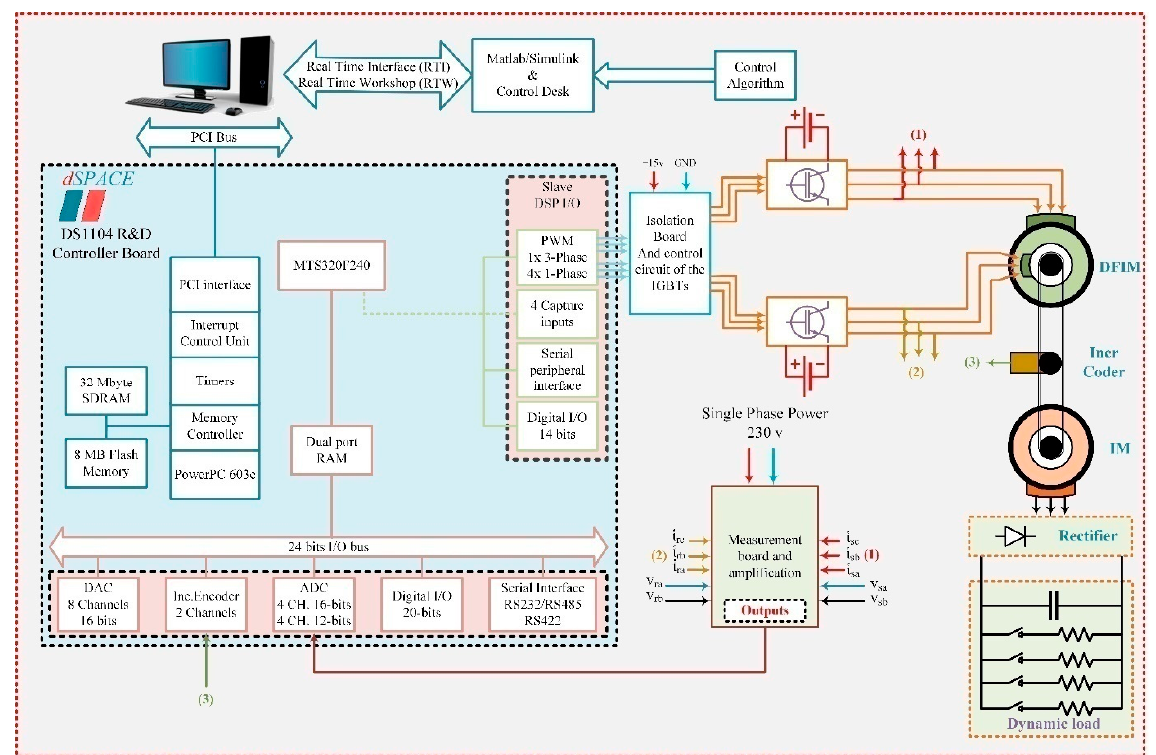
Figure 19. Image of the test bench.